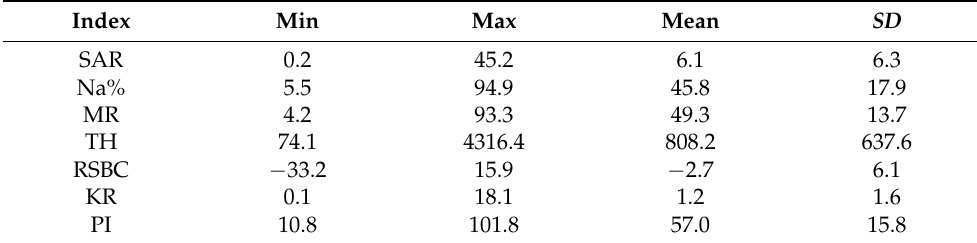
Table 3. Statistical summary of irrigation water indices used in this